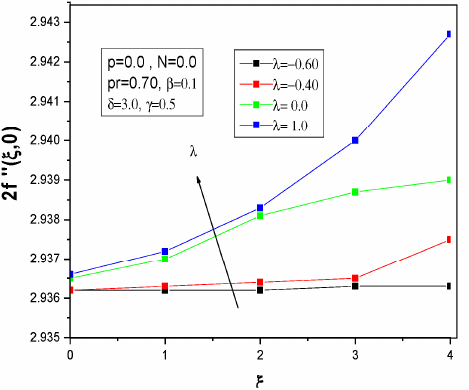
Figure 16. Effect of the temperature exponent and buoyancy force parameter on the skin friction coefficient.